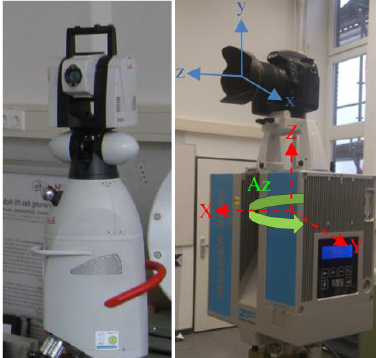
Figure 1. The employed sensors. Laser tracker (left), A D750 digital camera and Z+F Imager 5006 TLS and their corresponding coordinate systems (right) The calibration of the aforementioned hybrid sensor system can be separated into three single calibrations: calibration of the camera, calibration of the TLS and extrinsic calibration between TLS and digital camera. The interior orientation of the camera and internal error sources of the TLS can be determined in the laboratory to reach high accurate calibration values.